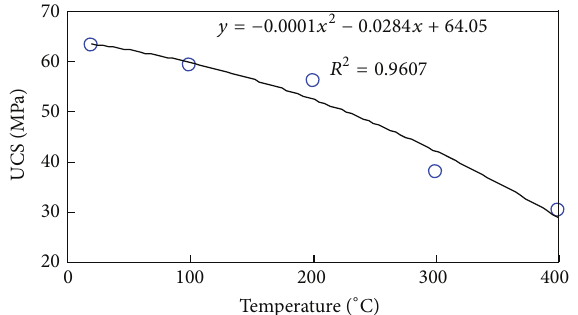
Figure 4: Uniaxial strength variation curve with temperature in granite.